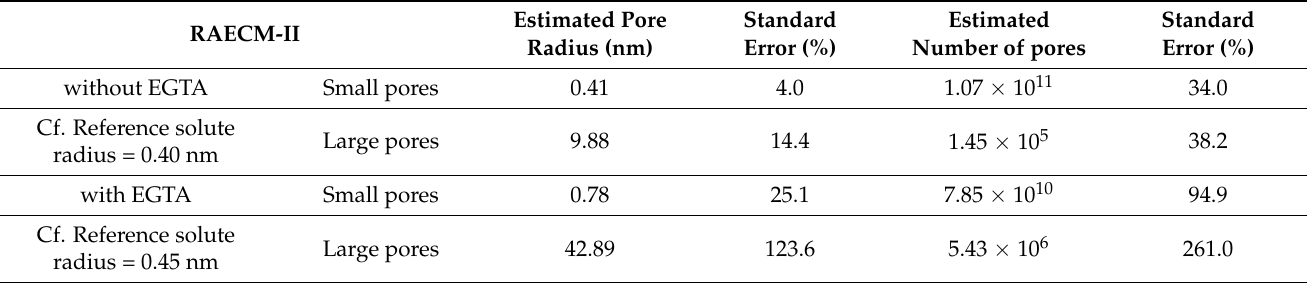
Table 7. Small and large equivalent pore areas and their fractions and fold changes in equivalent pore area in response to EGTA treatment of RAECM-II. Entries are based on the estimated values listed in Table 6. Equivalent pore area is per nominal surface area (1 cm 2 ) of RAECM-II.